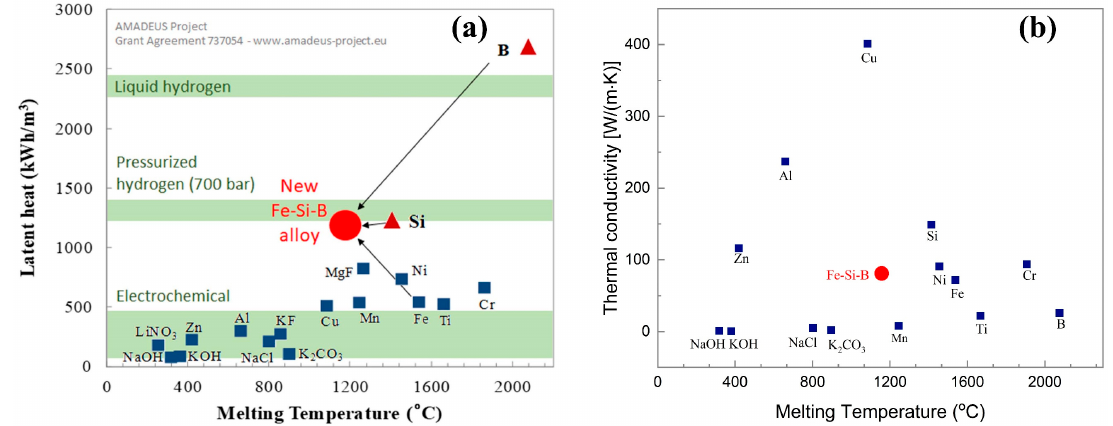
Figure 3. ( a ) Latent heat of fusion of different materials as a function of the melting temperature [19], ( b ) Thermal conductivity of different types of PCMs [29,30].